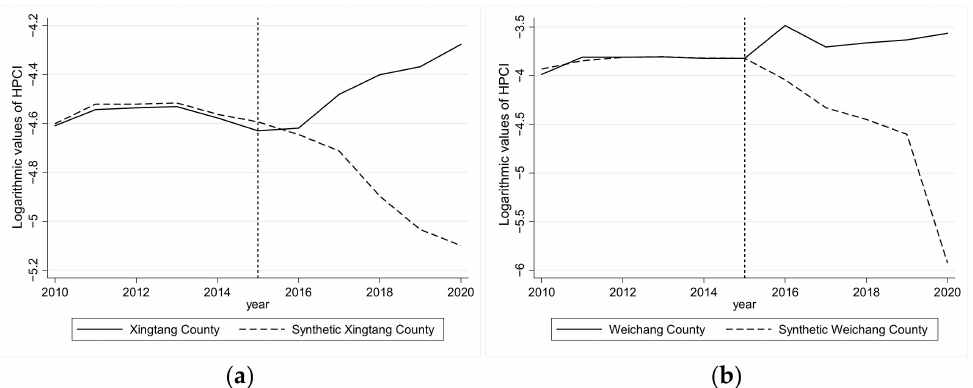
Figure 5. Effect of the CFFP on the herbivorous livestock production concentration index (HPCI), ( a ) the trend of Xingtang County and synthetic Xingtang County; ( b ) the trend of Weichang County and synthetic Weichang